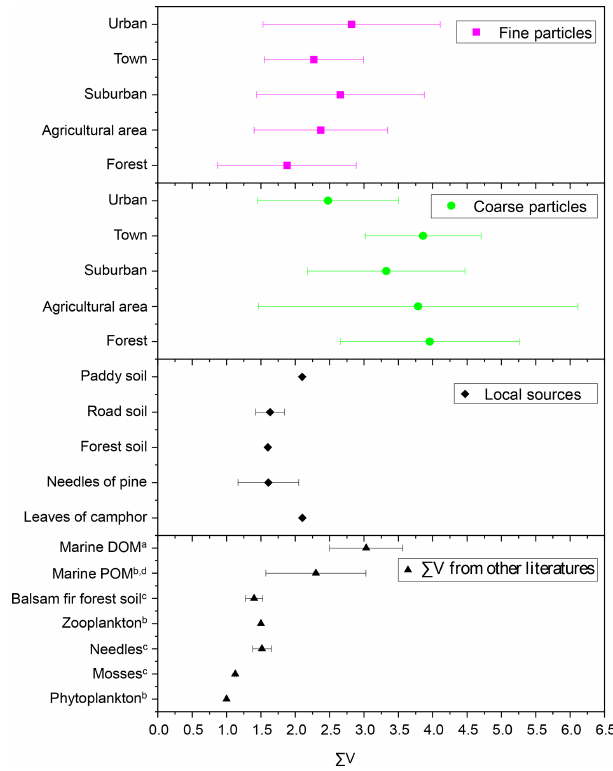
Figure 9. (cid:80) V values for fine and coarse particles in comparison to local natural sources and other studies. a Calleja et al. (2013). b Mc- Carthy et al. (2007). c Philben et al. (2018). d Batista et al.